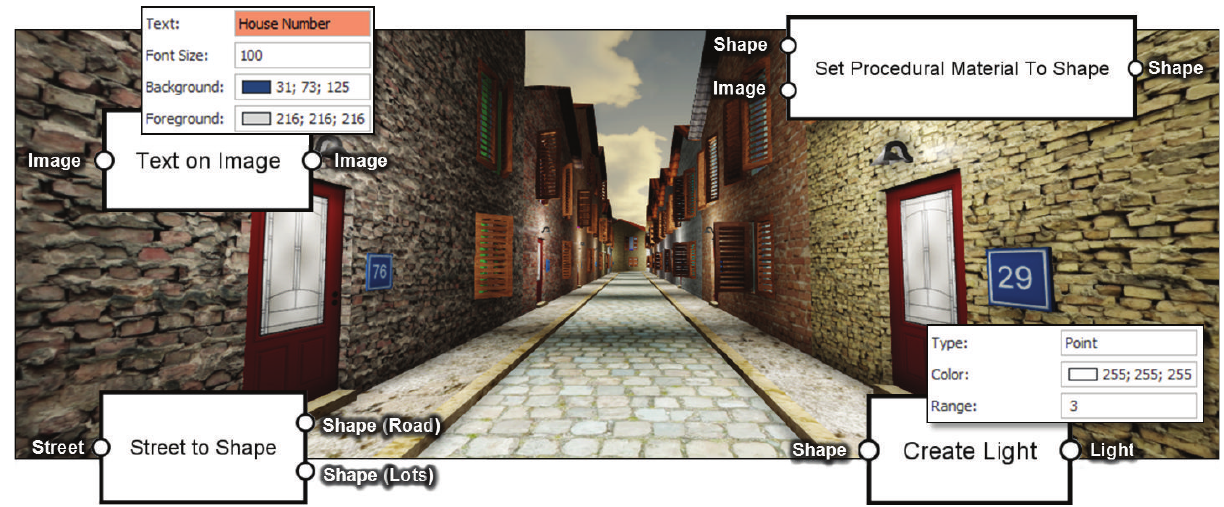
Figure 10: Manipulation of different entity types within the same scene. A street entity led to the generation of several buildings, represented as shapes. Each building was given a number which was then used to produce a custom texture to attach next to each door. Light sources were then instanced on the location of each street lamp, just above the doors. The generation of each entity type therefore greatly benefits when processed in sequence, in a single pipeline, instead of in separate